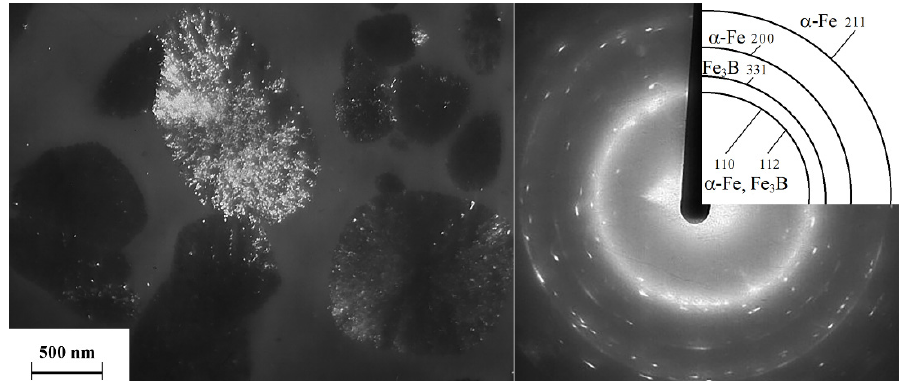
Figure 5. Dark-field image (TEM) of Fe(Cr)-(Fe,Cr) 3 B eutectic colonies in amorphous matrix of the Fe 70 Cr 15 B 15 AA annealed at T an = 743 K for 1 h.